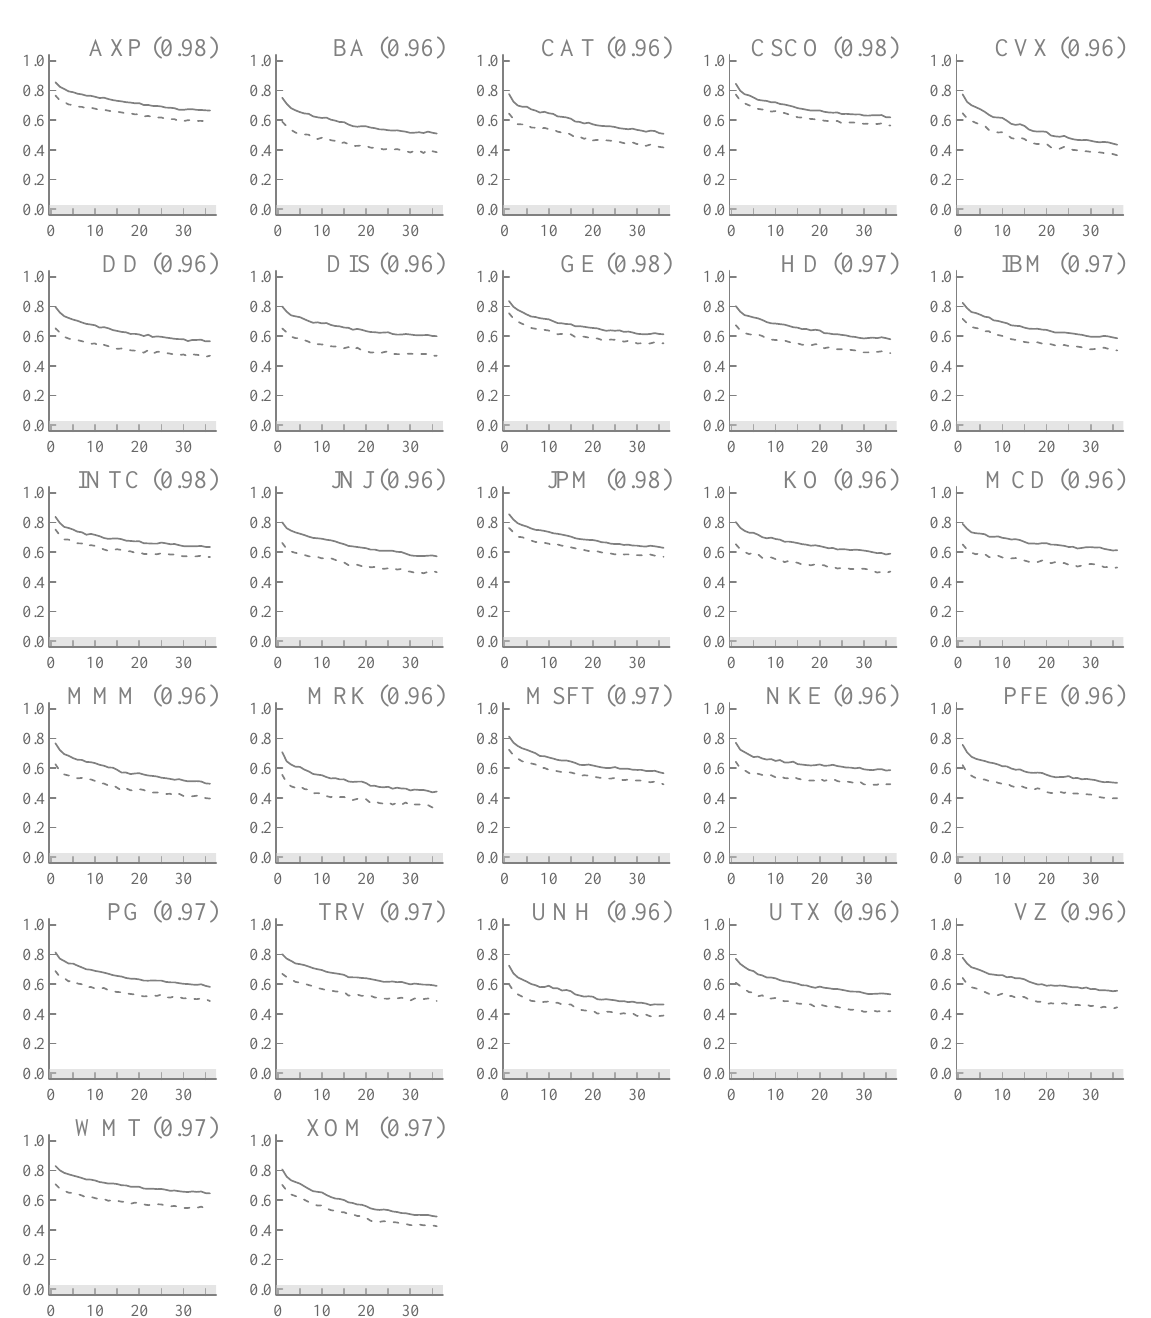
Figure A1. Sample autocorrelations of log realized variance (solid line) and log realized quarticity (dashed line). Numbers in parentheses next to the ticker symbols are the sample correlation between to the two log realized series. The shaded area is the two standard error band for a white noise process. The daily sample is from 22 April 1997 to 31 December 2013 (4200 trading